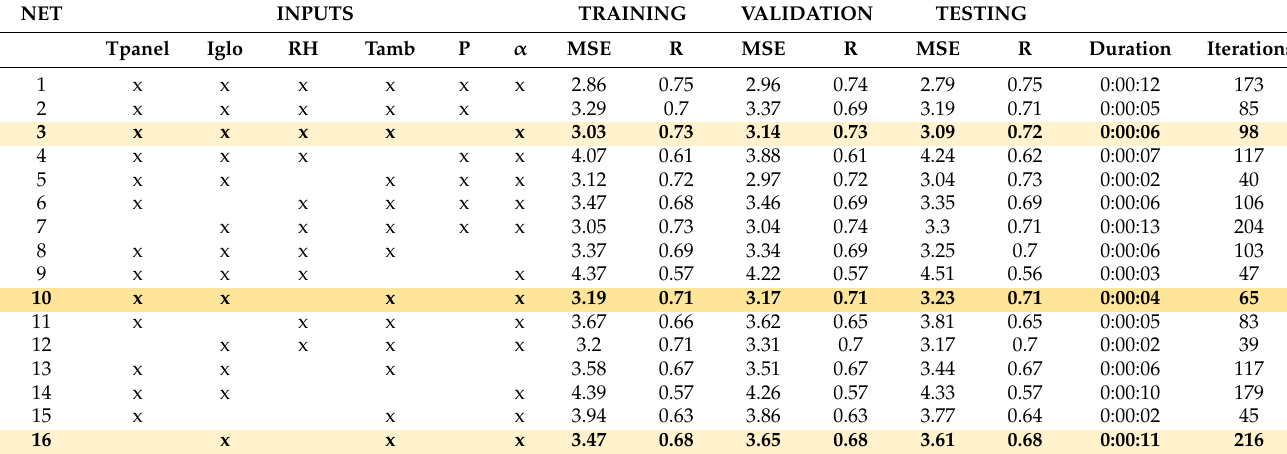
Table 3. Artificial neural network (ANN) Model 1 results with 10 neurons. NET: network; MSE: Mean square error.